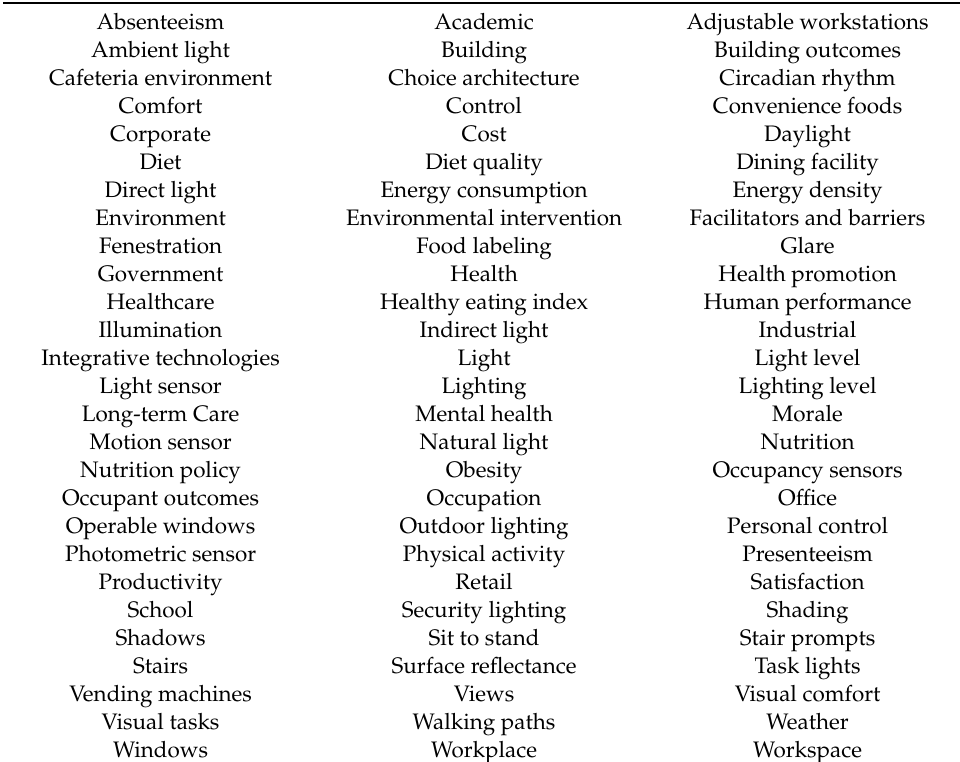
Table 1. Search terms for nutrition, physical activity, and natural and artificial